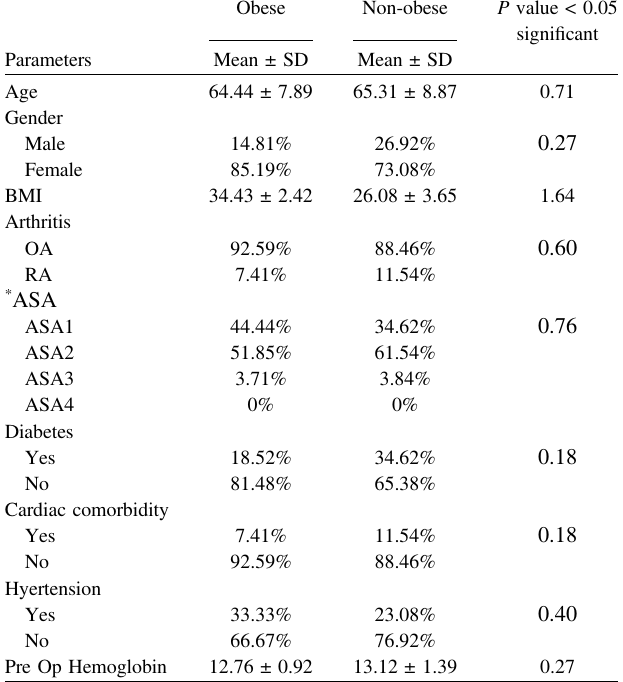
Table 1. Pre-operative demographics ’ comparison of the two groups. Obese Non-obese P value <